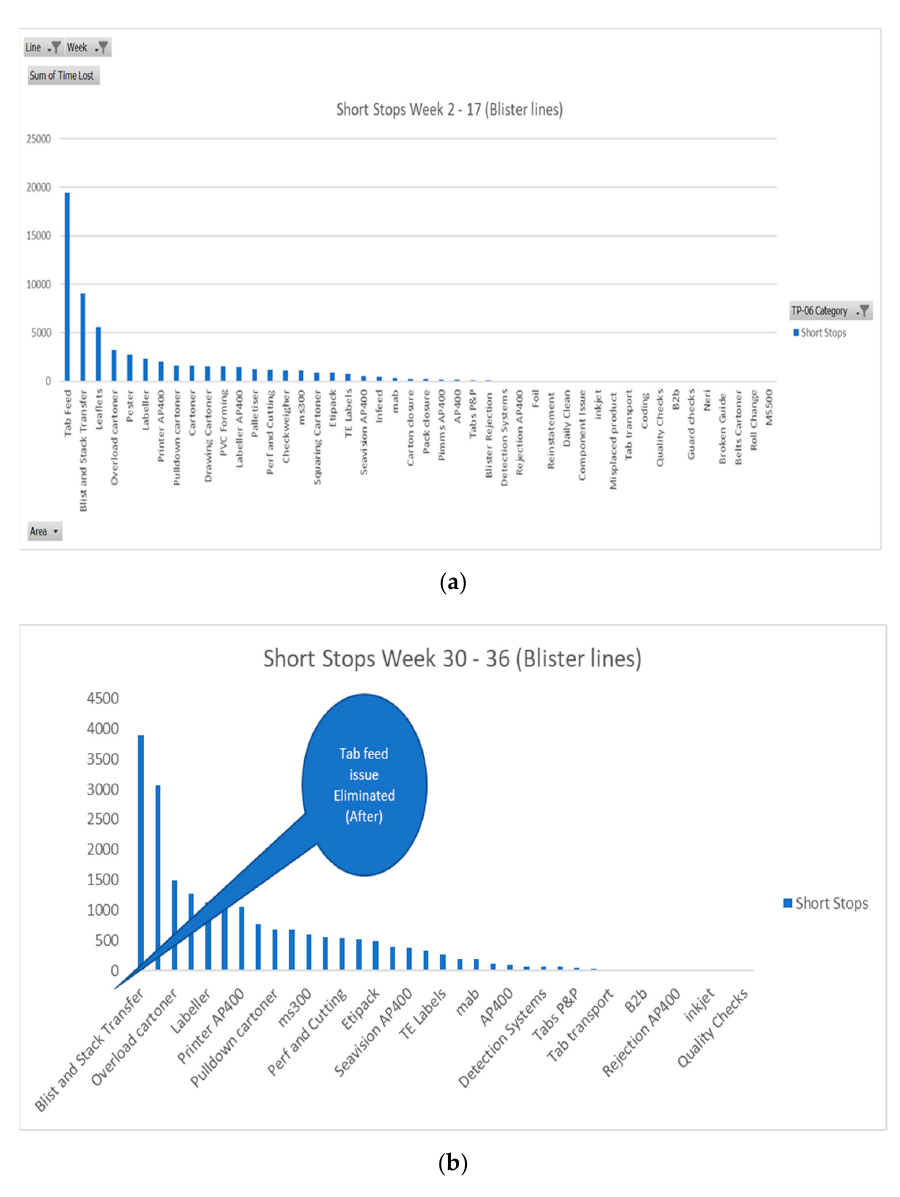
Figure 20. ( a ) Before the project started and actions were implemented, tab feed stops or downtime associated with tab feeds was the top downtime issue; ( b ) After the project implemented corrective actions, the tab fed issue was eliminated as a contributor to short stops or downtime.